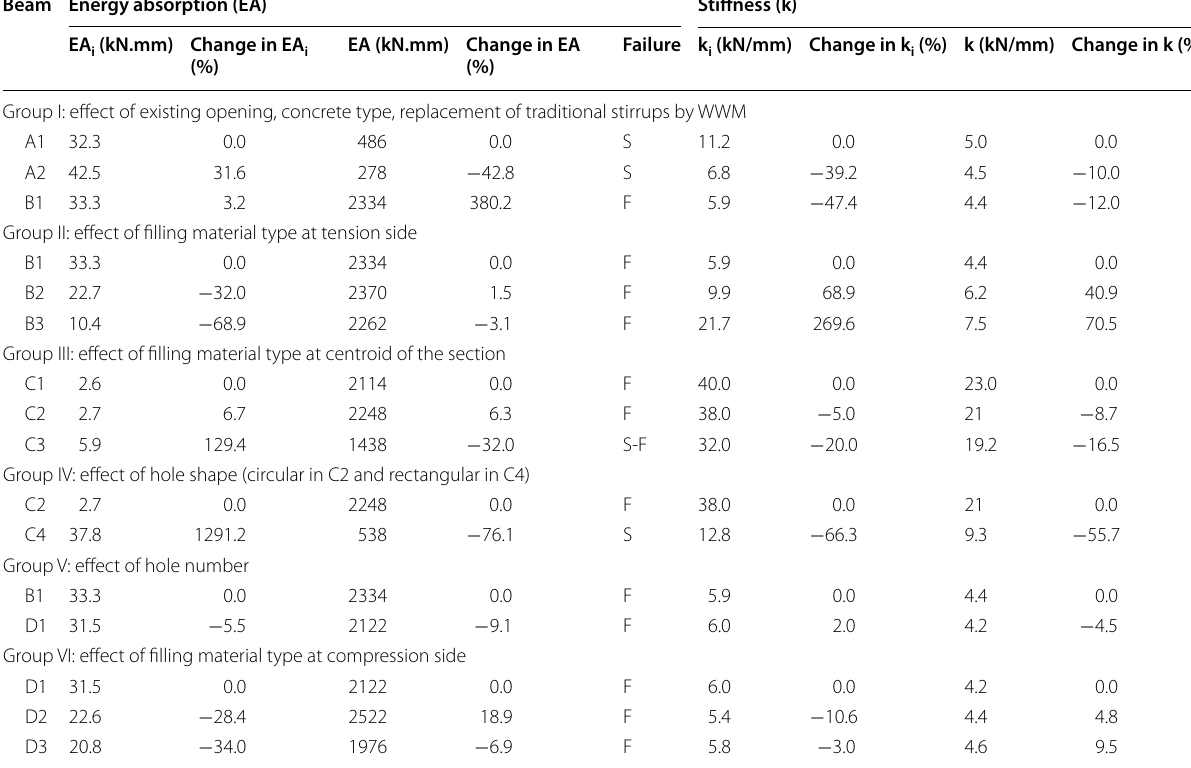
EA i and EA are energy absorption before and after cracking, respectively, which are estimated by area under load–deflection curve for each beam. k i and k are stiffness before and after cracking, respectively, which are estimated by slope of load–deflection curve for each beam. S and F are referring to shear and flexure failure